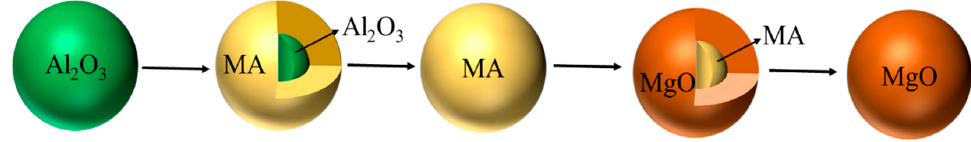
Figure 6. Reaction model of Al 2 O 3 inclusion in high-carbon hard wire steel treated by magnesium.